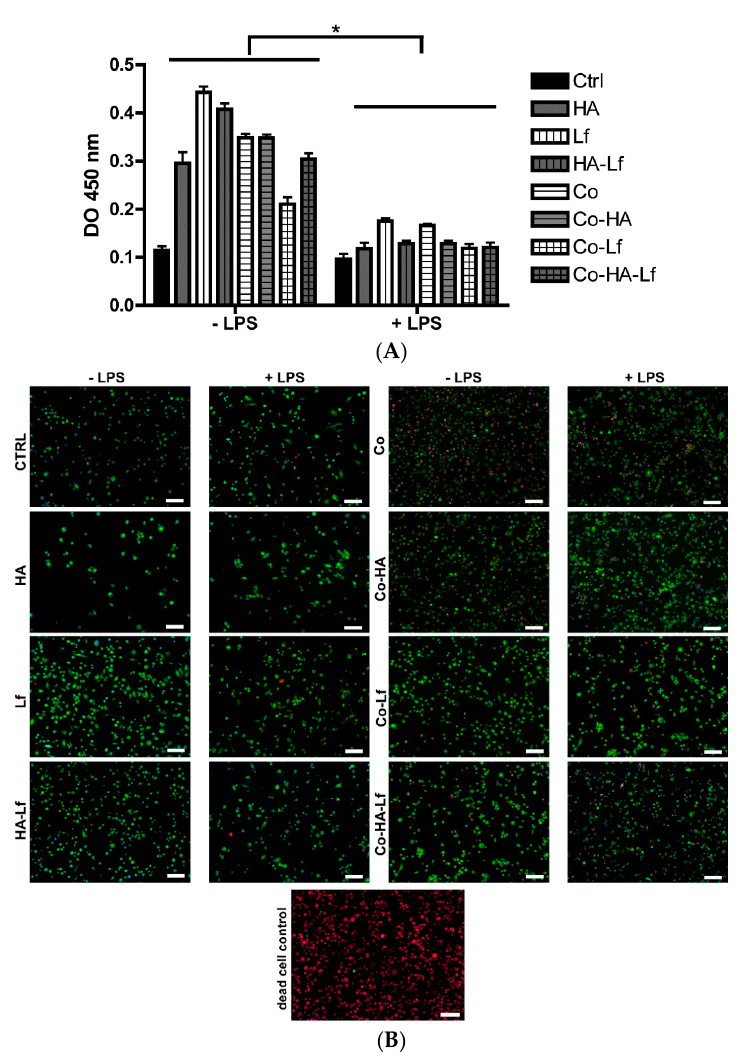
Figure 3. ( A ) Viability of THP-1 cells attached to surfaces coated with complex hybrid biomimetic components (Co, hydroxyapatite (HA), and lactoferrin (Lf)) in the absence or presence of LPS. Data are presented as mean values ± SD, and significance was determined at * p < 0.05; ( B ) Fluorescence microscopyimagesofmacrophage-differentiatedTHP-1cellsonbiomimeticmodifiedsurfaces(LIVE-DEAD method). The live cells are marked by green fluorescent calcein, and dead cells are labeled with the ethidium-1 homodimer in red. Images of fluorescence microscopy of THP-1 cells adhered for 72 h on